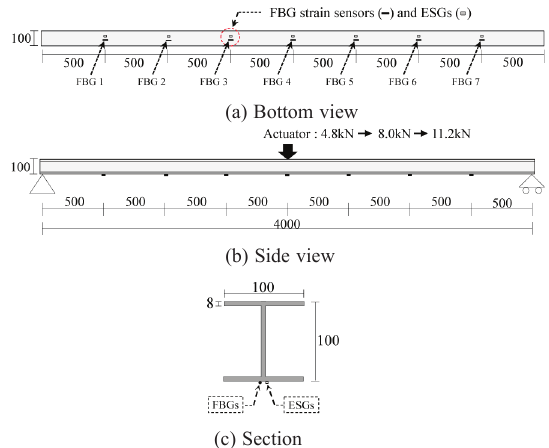
4. Experimental setup for test model (unit: